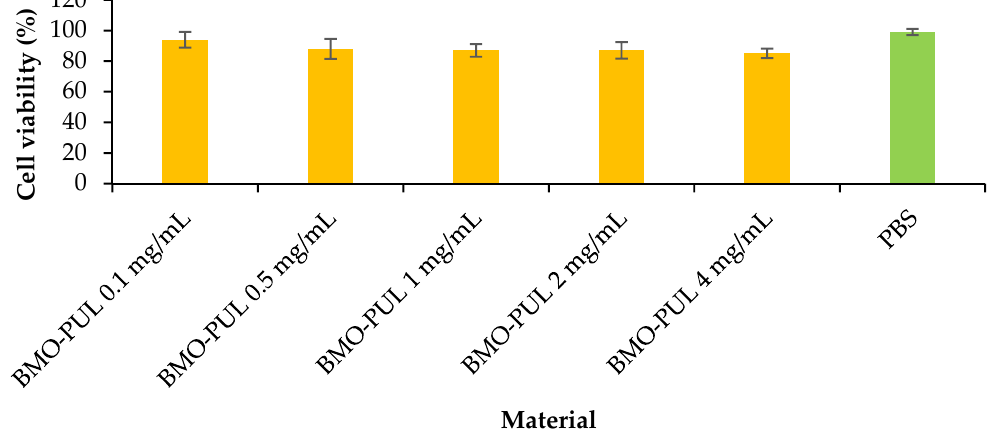
Figure 12. HaCaT cell viability data for α -arbutin-loaded BMO-PUL (concentration range 0.1–4 mg/mL) for 24 h (MTT assay; PBS as a control; n = 3; ± SD).